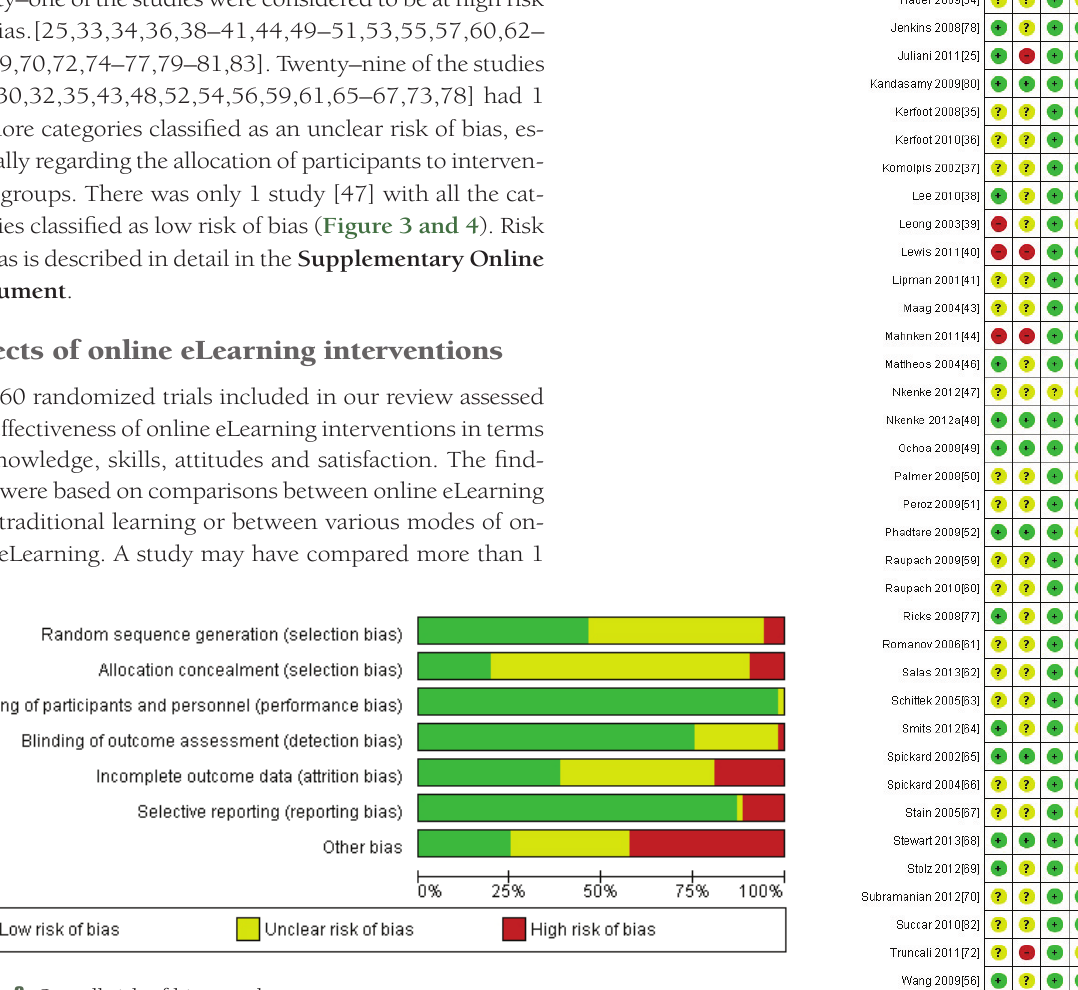
Figure 3. Overall risk of bias graph.